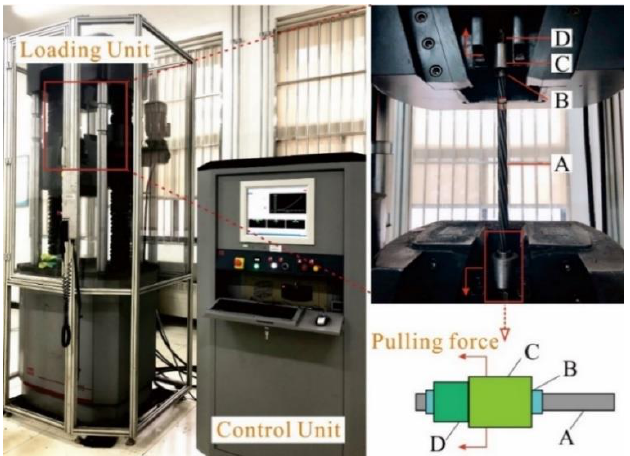
Figure 5. Test equipment: (A) denotes the rod body, (B) refers to the locking casing, (C) indicates the steel lagging, and (D) shows the nut.